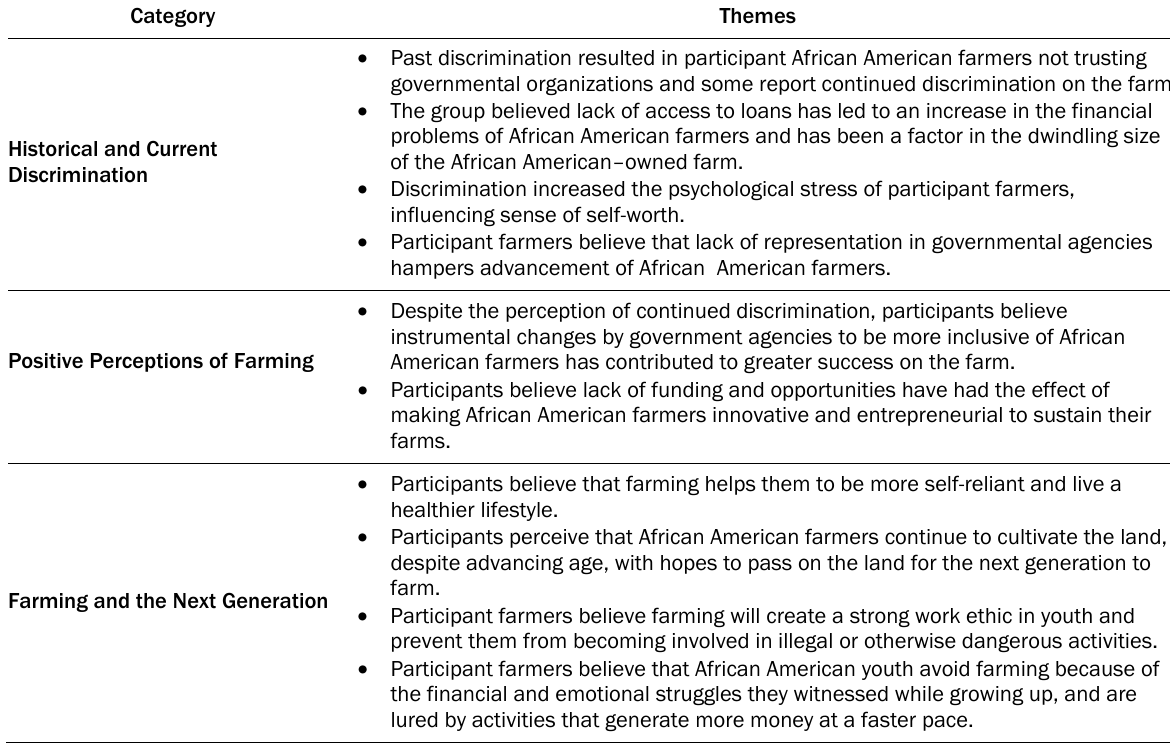
Table 2. Summary of Overarching Categories and